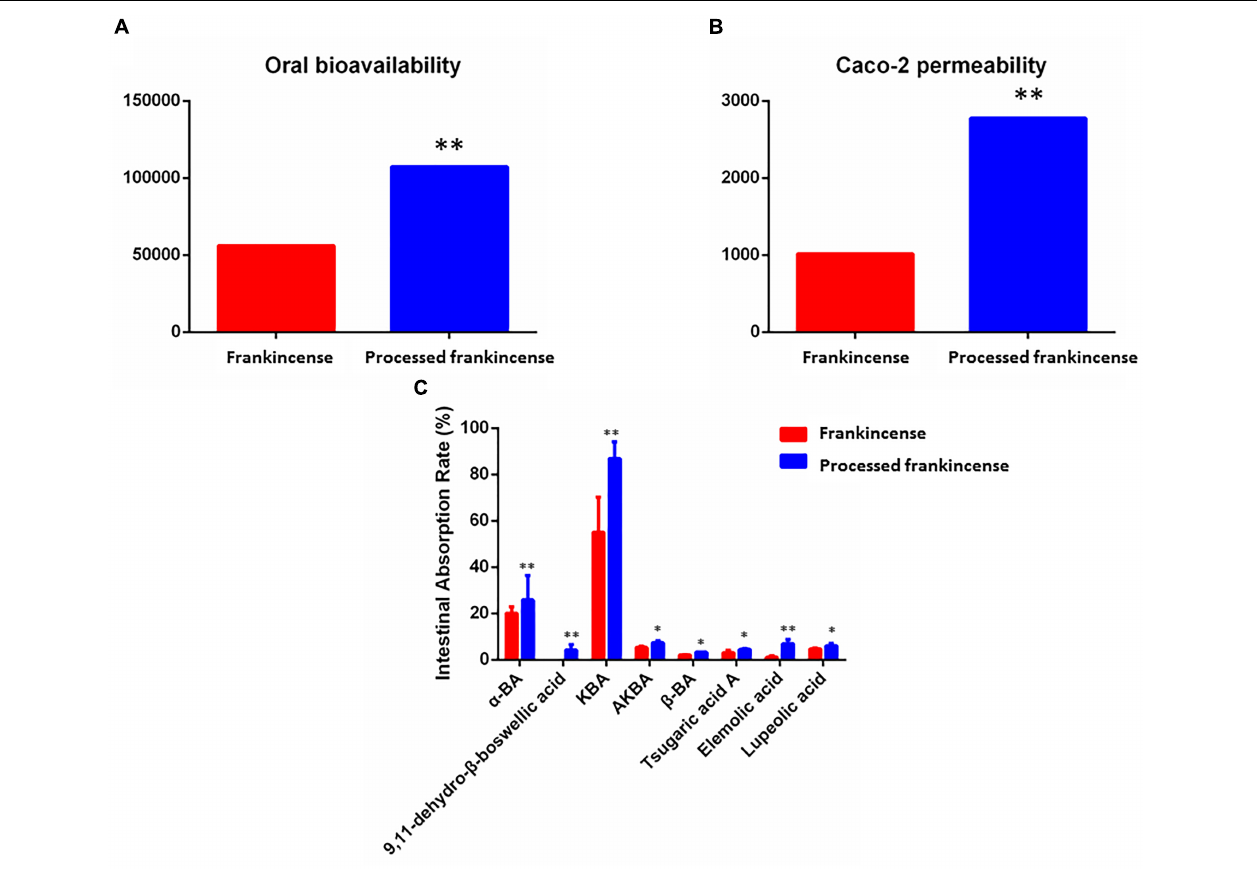
FIGURE 3 | Absorption prediction and validation of frankincense and processed frankincense. (A) OB predictive parameters of frankincense and processed frankincense. (B) Caco-2 predictive parameters of frankincense and processed frankincense. (C) Intestinal absorption rate of compounds in frankincense and processed frankincense. ( ∗ and ∗∗ P < 0.05 and 0.01, comparison with the frankincense